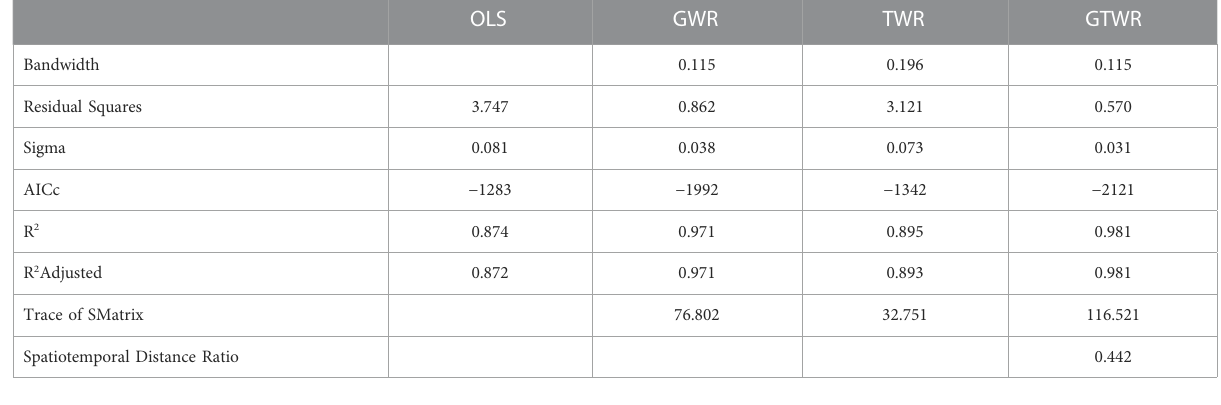
TABLE 7 Model selection and regression